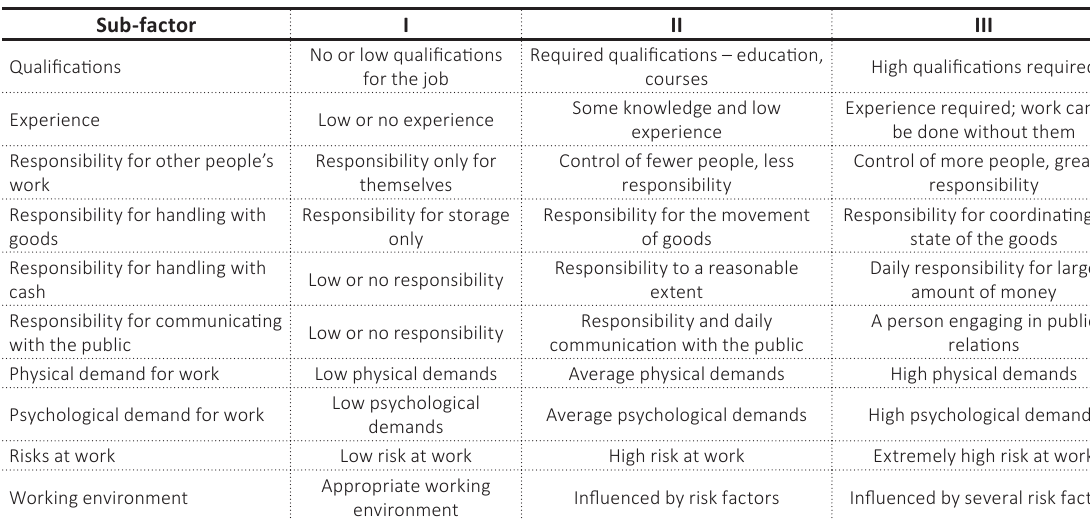
Table 2. Specifications of types of factors